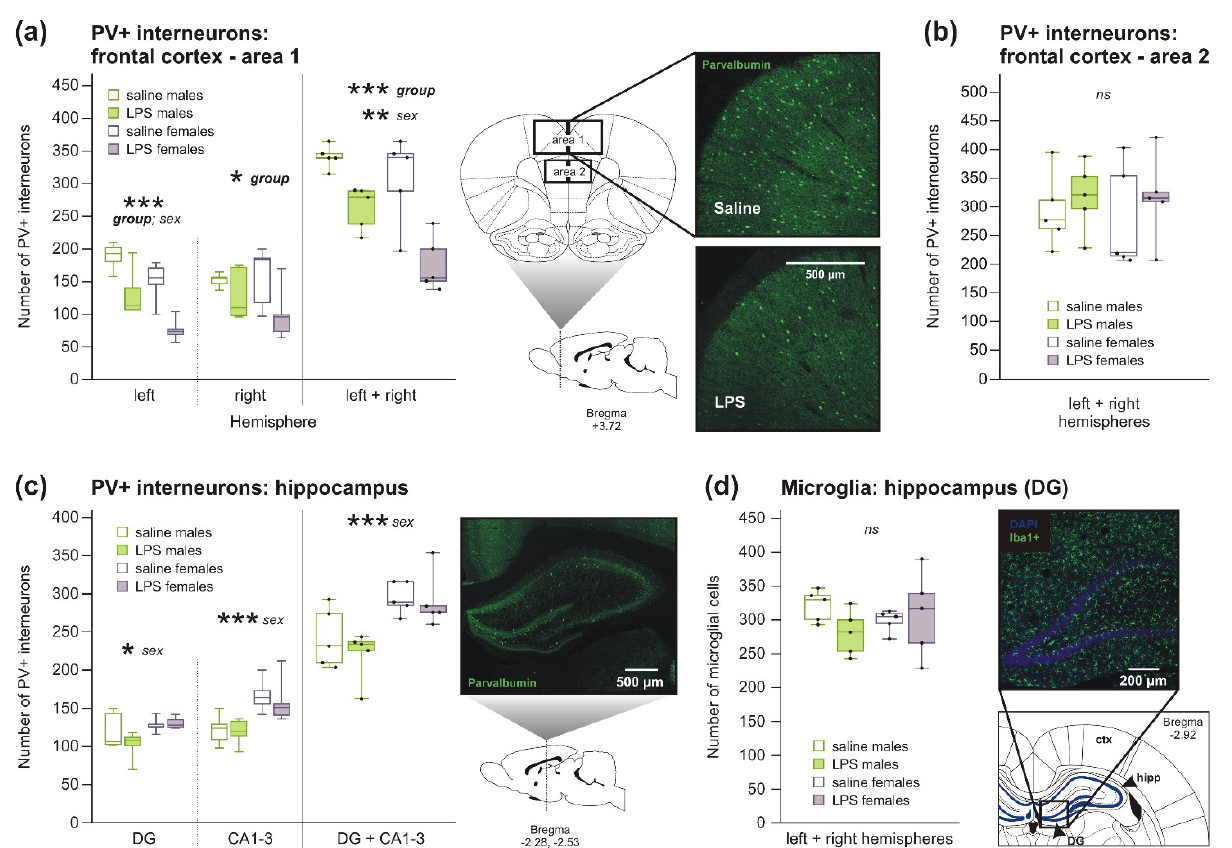
Figure 2. Parvalbumin-positive (PV+) interneurons and microglia in P28-old rats. ( a ) Number of PV+ interneurons was decreased in the upper part of the frontal cortex of both hemispheres (area 1), with the higher difference found in the left hemisphere, in both males and females prenatally exposed to LPS, as 2wANOVA analyses showed. Moreover, there was a sex difference with males showing higher density of PV+ interneurons, specifically in the left hemisphere. The graph shows averaged values from left and right hemispheres separately, and for an average of both. ( b , c ) The difference between groups in the number of PV+ interneurons located in lower part of the frontal cortex (area 2) ( b ), as well as in the dorsal hippocampus ( c ) was not significant, according to 2wANOVA. However, males in general showed lower number of PV+ interneurons in the dorsal hippocampus compared to females, more profound in CA1-3 areas than the dentate gyrus. ( d ) The number of microglia in the dentate gyrus of the dorsal hippocampus was also not affected by prenatal experience with LPS, according to 2wANOVA. The boxplots show median, first and third quartile, and minimum and maximum values; the dots show individual values. * p < 0.05, ** p < 0.01, *** p < 0.001, ns = no significance. ctx = cortex; DG = dentate gyrus; hipp =